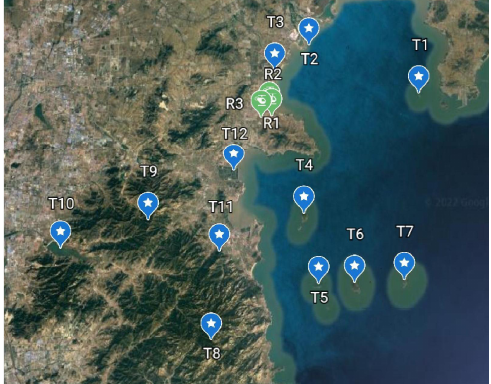
Figure 1. A typical MRTA problem scenario: three robots (green) to survey fourteen tasks